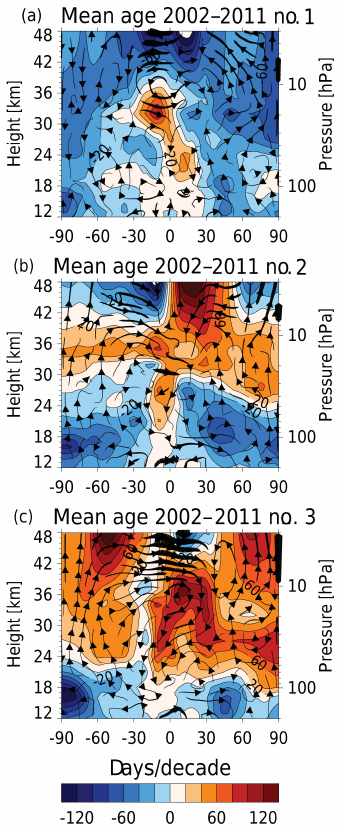
Figure 13. As in Fig. 2 but for changes in the BDC from Jan- uary 2002 to December 2011 in the annual mean of the three all- forcing ensembles. Note that the contour interval differs from Fig.